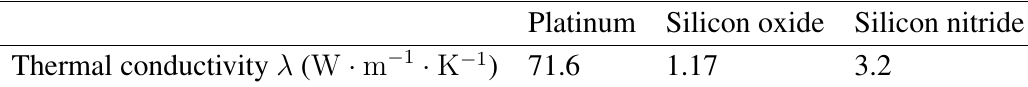
Table 1. Material thermal property